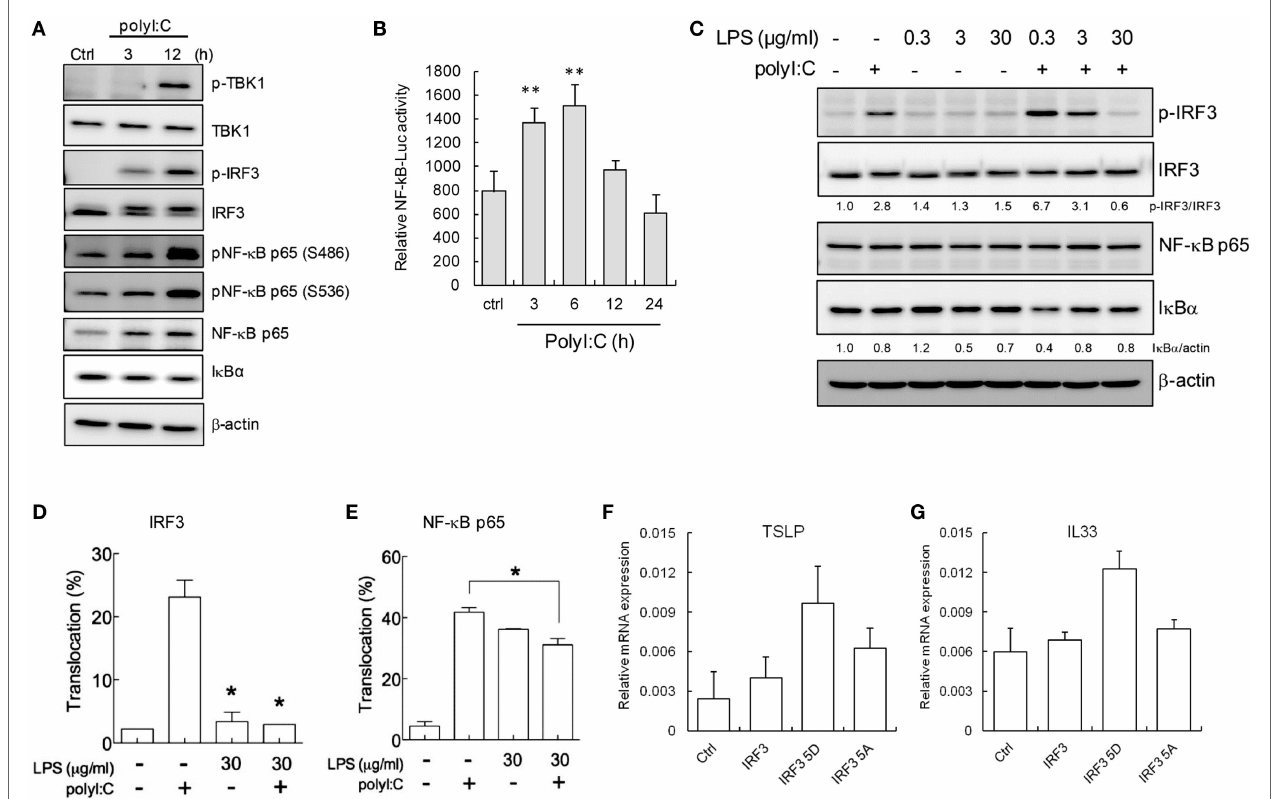
FigUre 2 | lPs downregulates polyi:c-triggered interferon regulatory factor 3 (irF3) and nF- κ B activation . (a) H292 cells were stimulated with polyI:C (2.5 μ g) for 3 and 12 h. Total cell extracts underwent SDS-PAGE and immunoblotting with specific antibodies. Data shown are representative of three different experiments. (B) Dual-luciferase assay of NF- κ B luciferase reporters. H292 cells transfected with Luc reporter (0.6 μ g) and pRL-TK (0.06 μ g) were treated with polyI:C (2.5 μ g) for 3–24 h. Data are mean ± SD from three independent tests. ** P ≤ 0.01 vs. untreated group. (c) H292 cells were pretreated with doses of LPS as indicated for 2 h and then stimulated with polyI:C (2.5 μ g) for 3 h. Cell extracts underwent SDS-PAGE and immunoblotting with specific antibodies. The signaling proteins expression level was analyzed by density meter and normalized to untreated control. Data shown are representative of three different experiments. (D,e) IRF3 and NF- κ B p65 nuclear translocation was measured by immunofluorescence assay in H292 cells treated with LPS (30 μ g/ml) for 2 h, then polyI:C stimulation for 3 h. Nuclear translocation rate is shown as mean ± SD from three observed fields. * P < 0.05 compared to controls. (F,g) H292 cells were transfected with control vector, wild-type IRF3, IRF3 5D (constitutive active IRF3), and IRF3 5A (dominate negative IRF3) for 48 h. The expression of TSLP and IL33 mRNA were measured by RT-qPCR and normalized to the internal control GAPDH. Values represent the average of three independent experiments ±